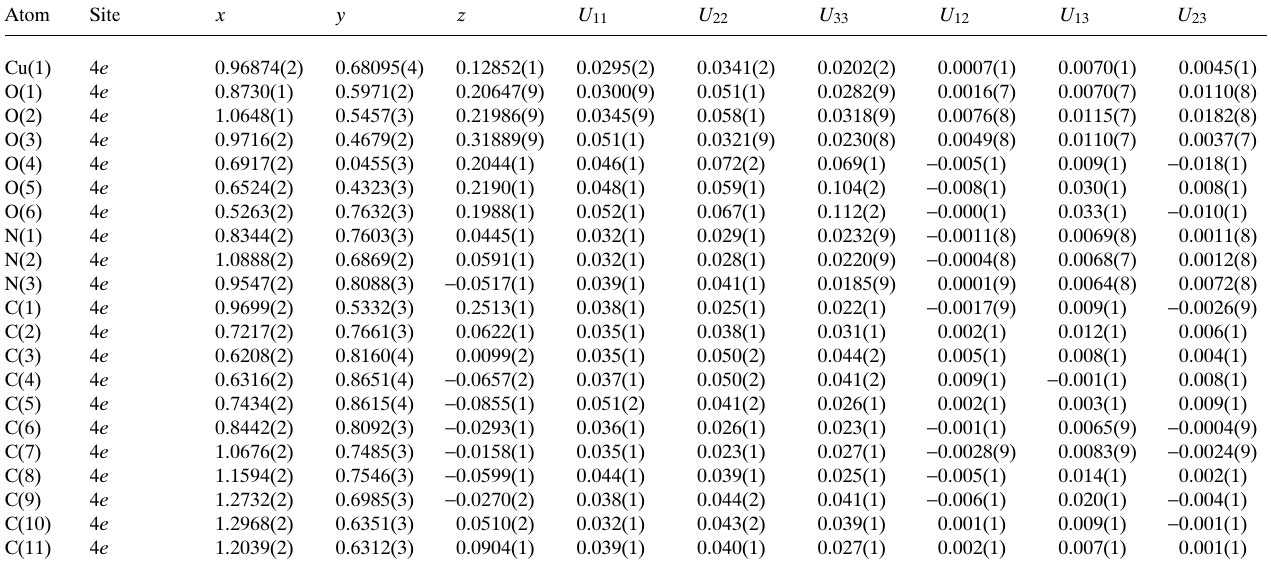
Table 3. Atomic coordinates and displacement parameters (in Å 2 ) .